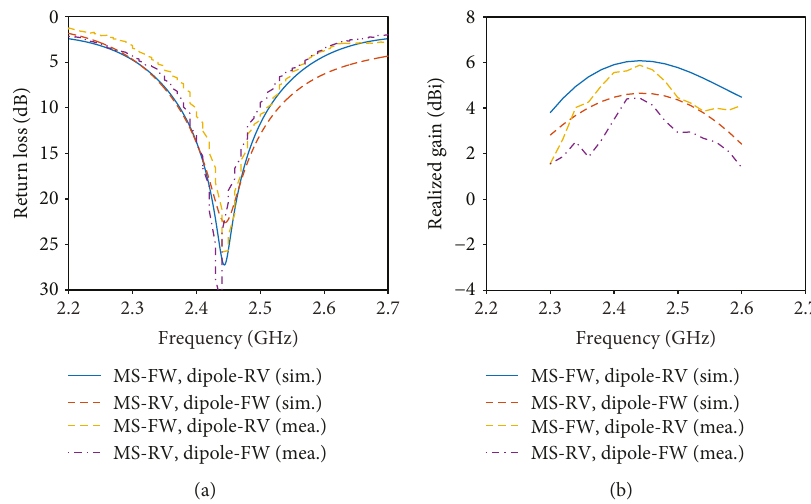
Figure 4: Comparison of simulated and measured (a) return loss and (b) gain of the proposed PIN diode-based recon fi gurable metasurface antenna operating in forward and reverse bias states of PIN diodes. (Notations: MS: metasurface; FW: forward bias; RV: reverse